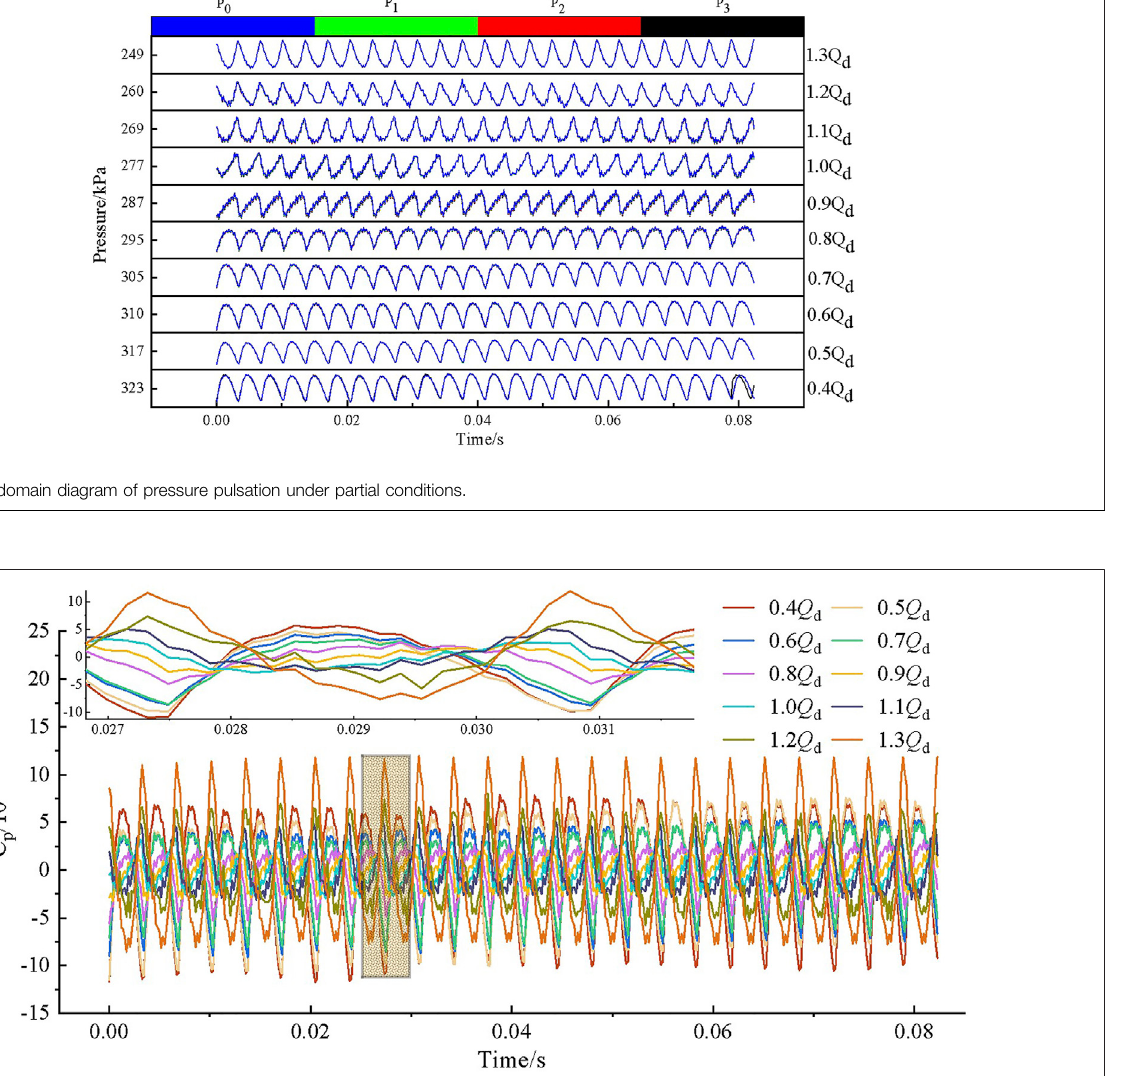
Frontiers in Energy Research |